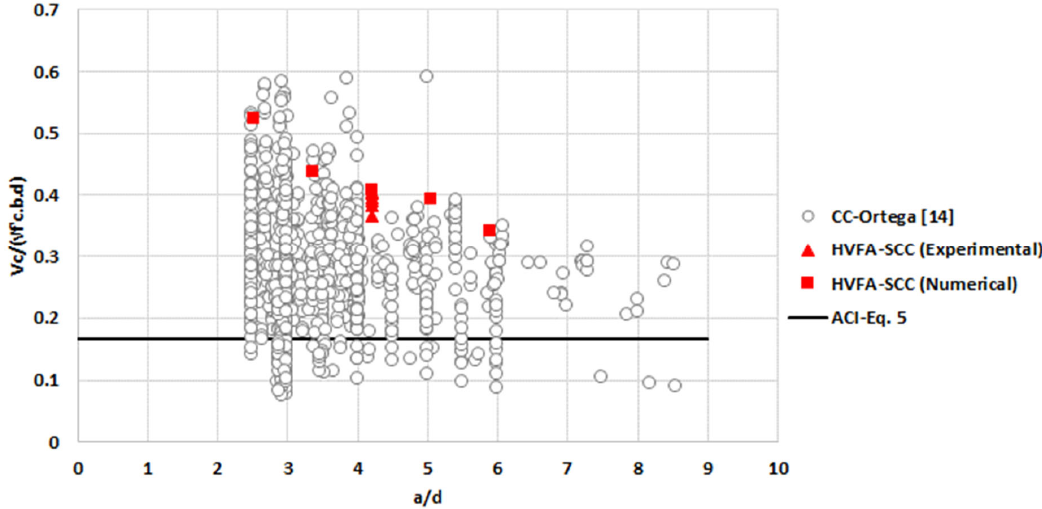
Figure 17. HVFA-SCC shear strength in the database of normalized shear strength vs. shear span to beam effective depth ratio.